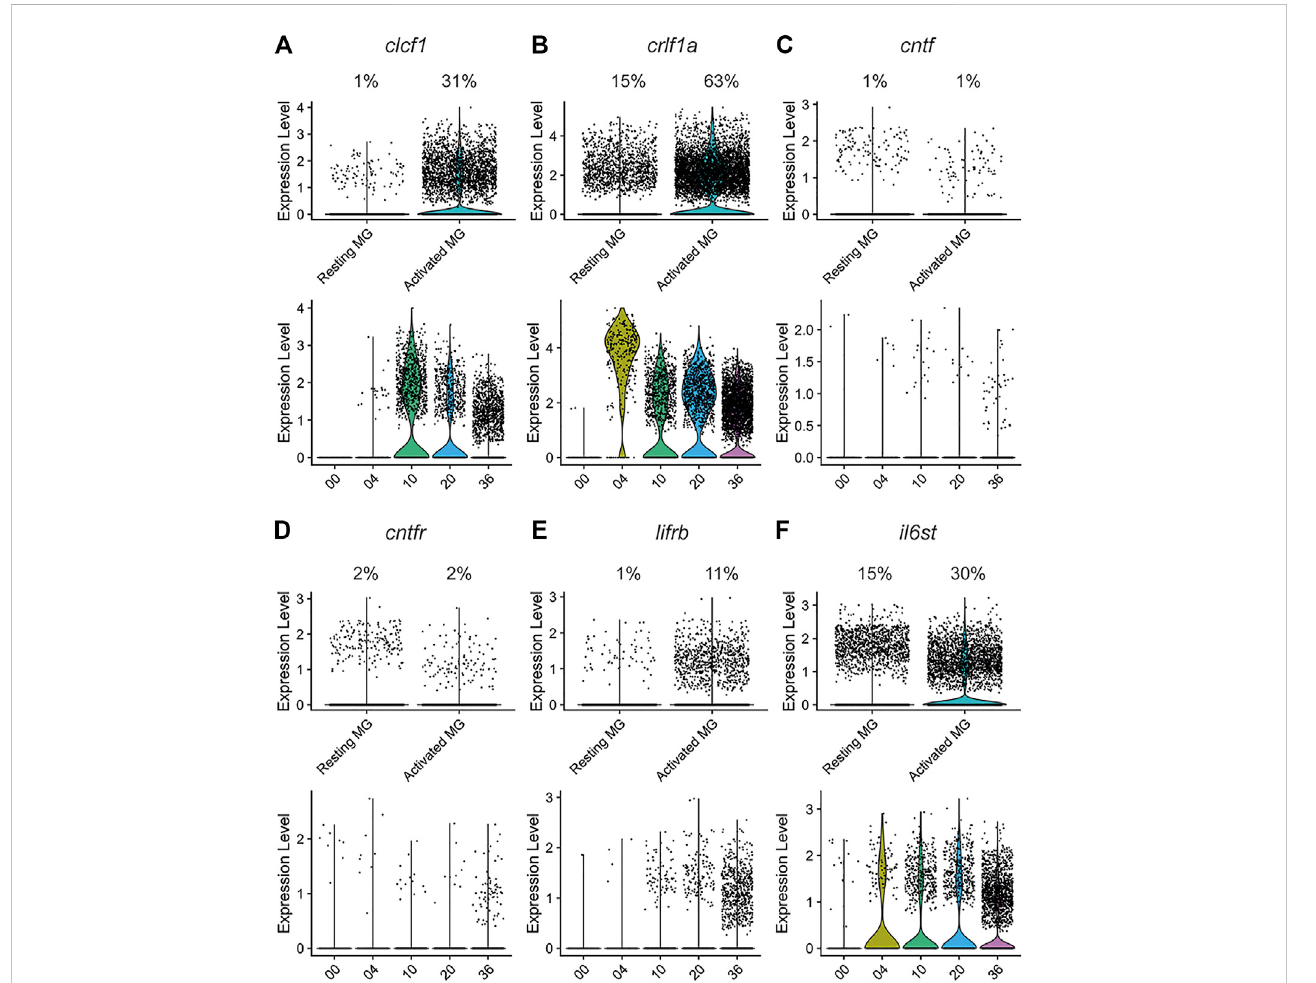
FIGURE 2 The CNTFR ligands clcf1 and crlf1a, but not cntf, are differentially expressed by activated Müller glia during regeneration in the light-treated retina. The expressionof clcf1 (A) , crlf1a (B) , cntf (C) , cntfr (D) , lifrb (E) ,and il6st (F) wereexaminedinasingle-cellRNA-Seqdataset(Hoangetal.,2020).Upperviolinplots shownumberofUMIexpressedinindividualrestingandactivatedMüllerglia.PercentageofMüllergliaineachclusterexpressingthegeneofinterestisshown above the plot. Lower violin plots show number of UMI expressed across time in activated Müller